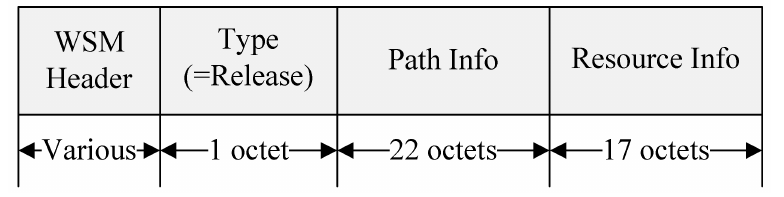
Figure 12. The format of the proposed Coop Release